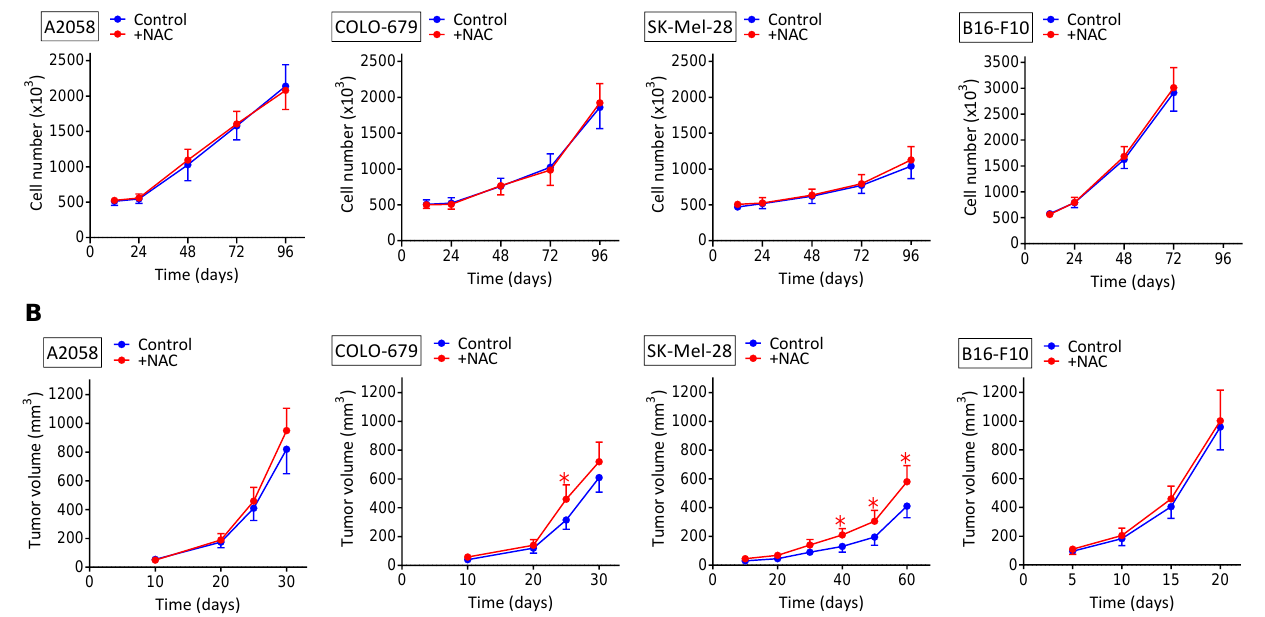
Figure 1. Effect of NAC on the rate of melanoma growth in vitro and in vivo. ( A ) NAC (2 mM) was added to the culture medium 24 h and 72 h after seeding. All data are mean values ± SD of 5–6 different experiments. No significant differences were found comparing NAC-treated cells versus controls. ( B ) NAC (240 mg/kg × day) was administered for 2 weeks, starting on day 14 in mice bearing A2058 or COLO-679 melanoma, on day 21 in mice bearing the SK-Mel-28 melanoma, and on day 5 in mice bearing the murine B16-F10 melanoma. All data are mean values + SD (n = 15 mice). * Significantly different p < 0.05, comparing NAC-treated mice versus controls treated with vehicle.